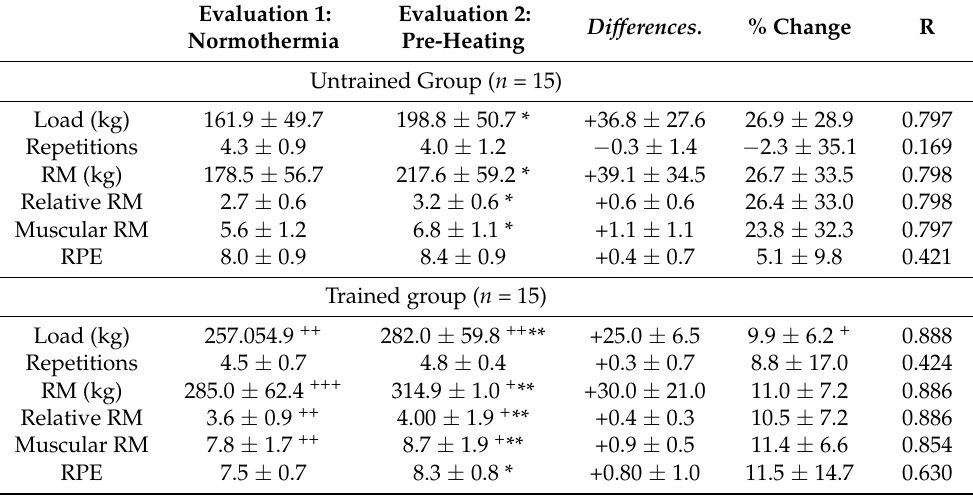
Table 3. Results of strength